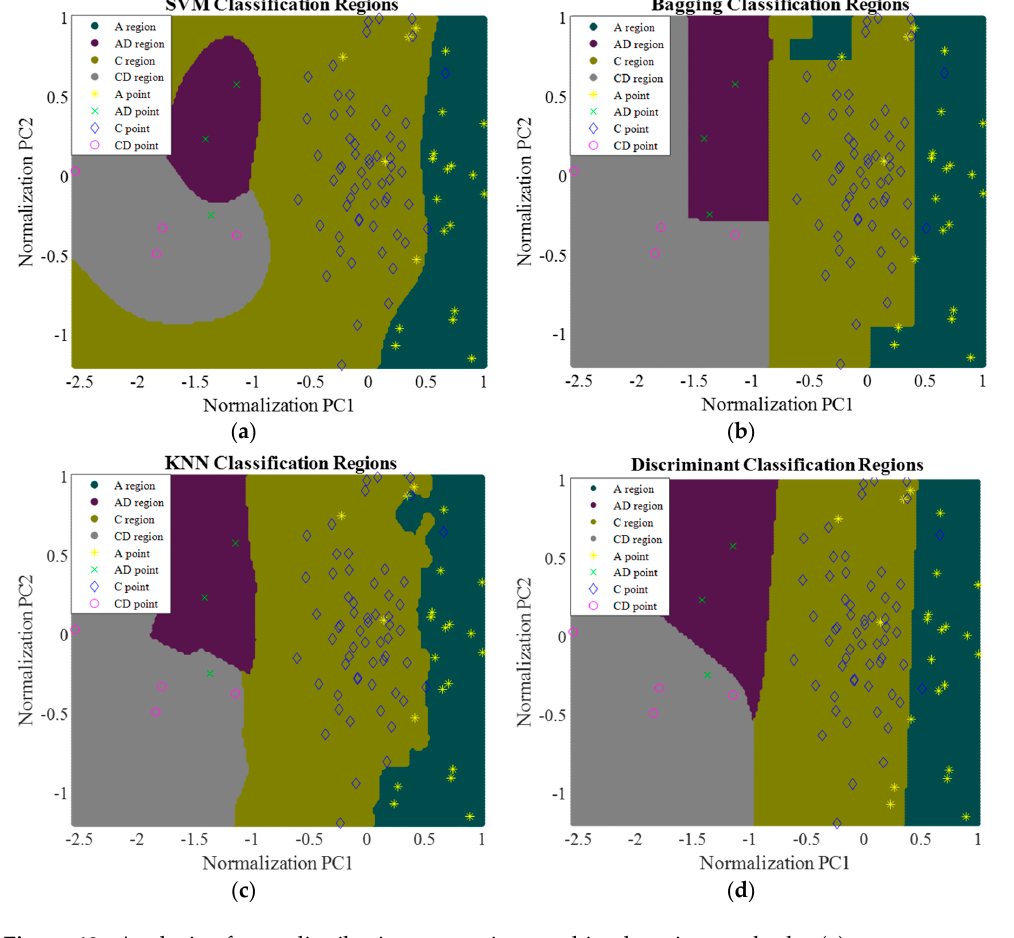
Figure 12. Analysis of post-distribution area using machine learning methods: ( a ) support vector machine (SVM) classification; ( b ) bagging classification; ( c ) k-nearest neighbor (kNN) classification; ( d ) discriminant analysis (DA) classification.